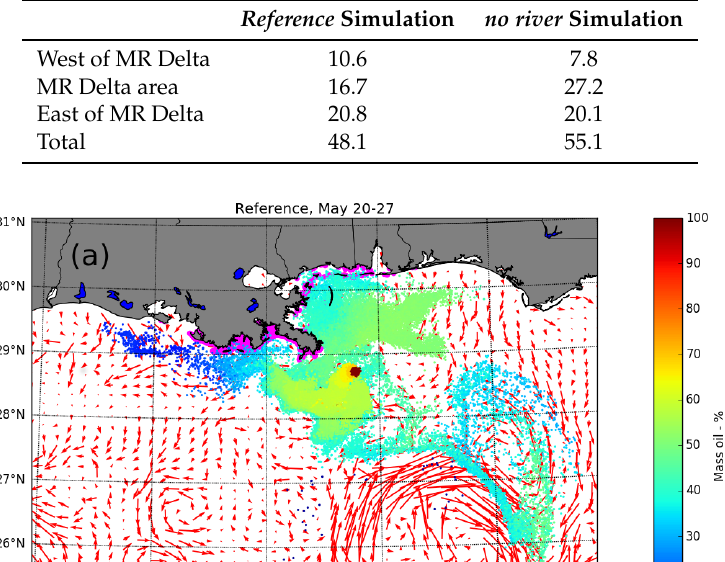
Table 3. Percentages of stranded oil elements for the July 2–10 simulations.